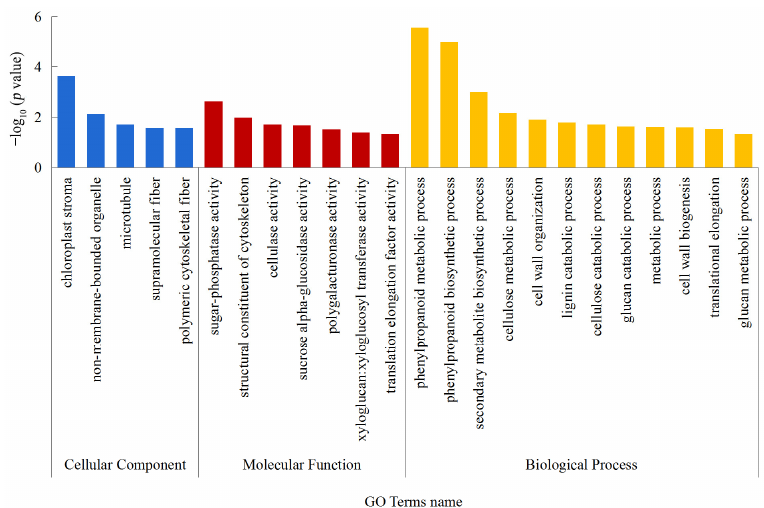
Figure 4. GO annotation statistics of differentially expressed proteins. The abscissa represents GO Level 2 annotation information, including cellular components, molecular functions, and biological processes; which are distinguished by blue, red, and orange, respectively. The ordinate represents the p value of each functional category (taking the negative common logarithm, i.e., − log 10 p value).